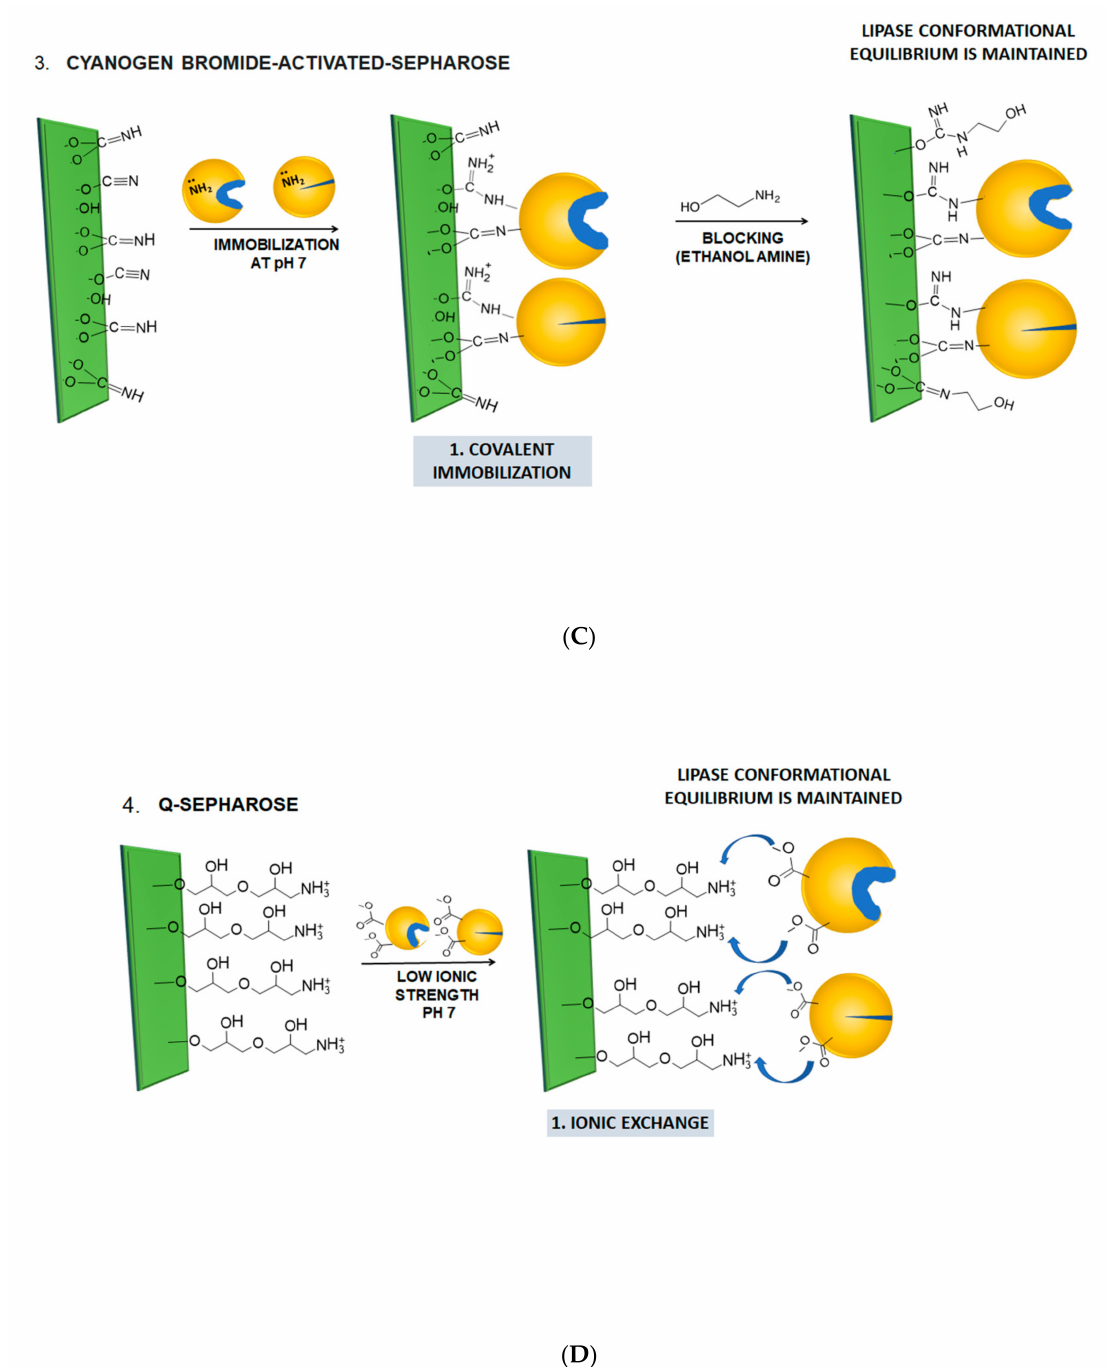
Figure 1. Different immobilization protocols used in this research. ( A ): Immobilization on octil-Sepharose; ( B ): Immobiliza- tion on octyl-glyoxyl Sepharose; ( C ): Immobilization in BrCN-Sepharose; ( D ): Immobilization in